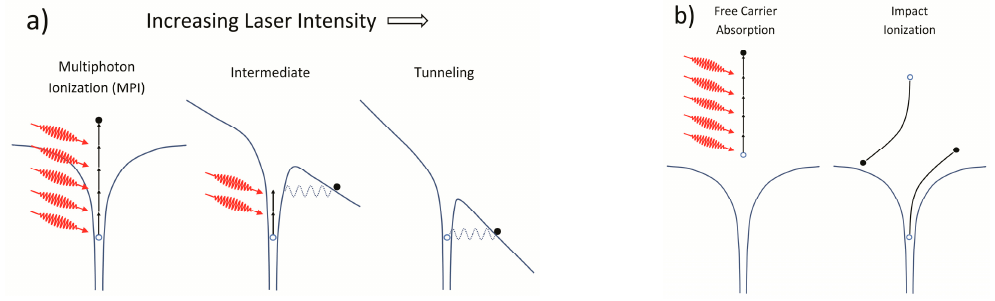
Figure 1. Schematic of free electron plasma formation with high intensity pulses where ( a ) multiphoton and tunneling ionization generates free electrons that ( b ) absorb radiation and impact-ionize surrounding material resulting in avalanche ionization.